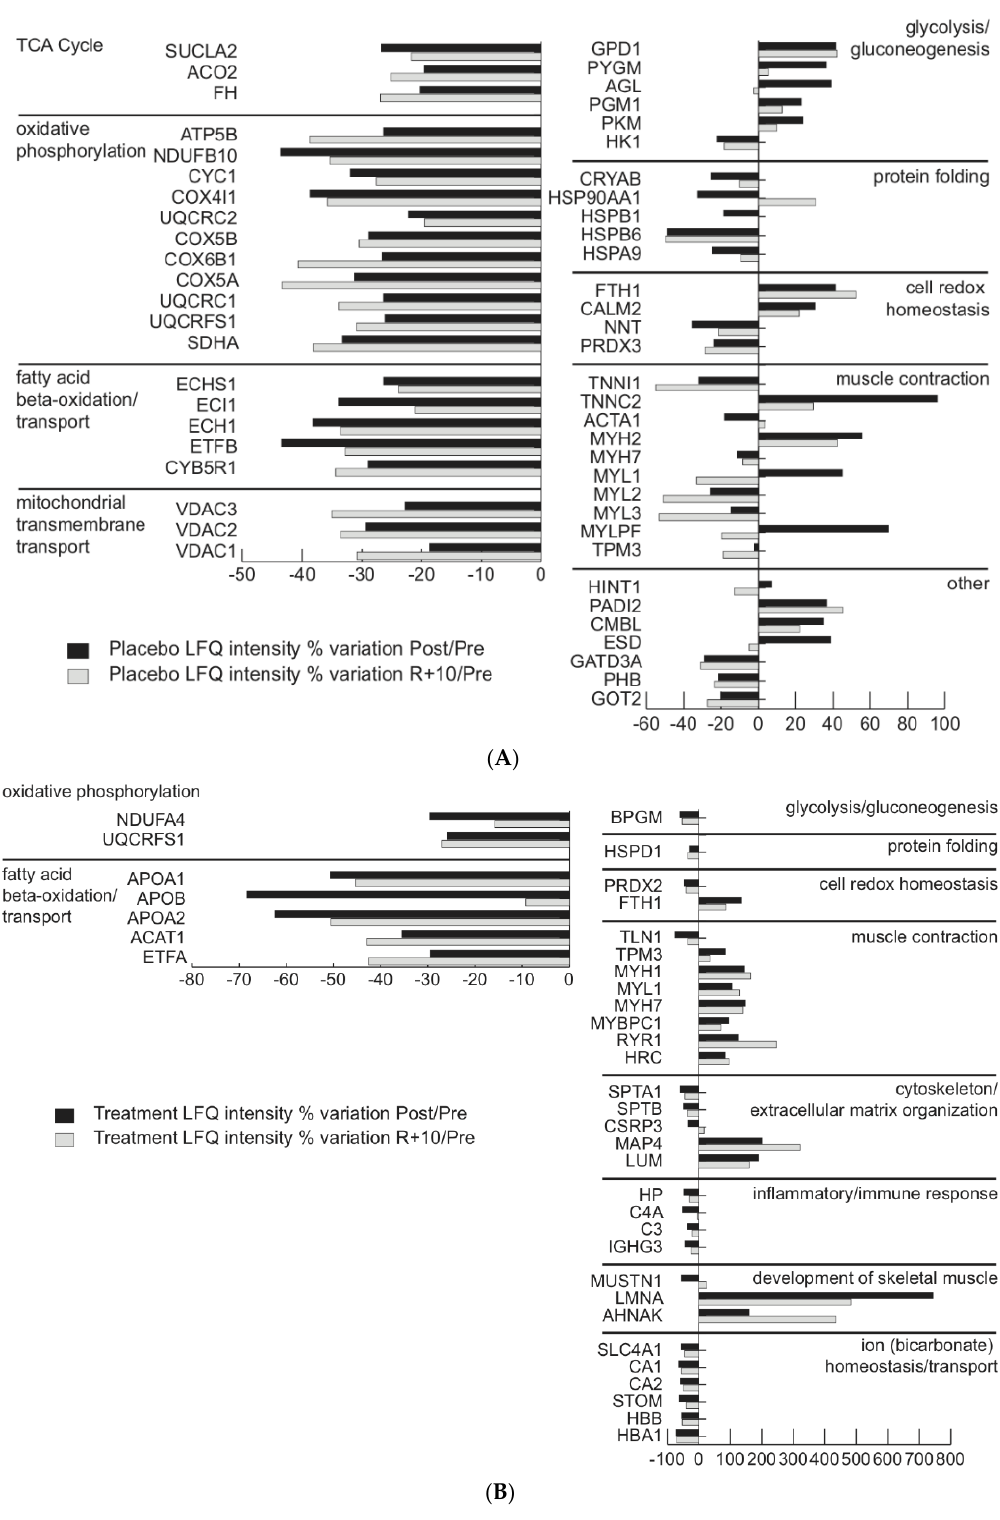
Figure 1. ( A ) Proteomic analysis of vastus lateralis ( VL ) muscles in the Placebo group. Histograms of differentially expressed proteins (label-free quantification (LFQ), intensity % variation, ANOVA and Tukey’s test, n = 5, p ≤ 0.05) in bedrest Placebo-Post (black bars) and Placebo-R + 10 subjects (gray bars) vs. Placebo-Pre condition. The individual variability within the group (Pre, Post, and R + 10) is shown in Figure S1. ( B ) Proteomic analysis of VL muscles in the Treatment group. Histograms of differentially expressed proteins (LFQ intensity % variation, ANOVA and Tukey’s test, n = 5, p ≤ 0.05) in bedrest Treatment-Post (black bars) and Treatment-R + 10 subjects (gray bars) vs. Treatment-Pre condition. The individual variability within the group (Pre, Post, and R + 10) is shown in Figure S2. Figure 1B graphically shows results from label-free LC – MS/MS differential analysis reported in Table S2 and indicates levels of proteins that are dysregulated by BR in Treat- ment-group in both Post and R + 10 vs. Pre. As a result, oxidative phosphorylation, cyto- chrome c oxidase subunit NDUFA4, and cytochrome b-c1 complex subunit Rieske (UQCRFS1) were decreased. Furthermore, fatty acid oxidation and lipid transport pro- teins were decreased. The glycolytic protein bisphosphoglycerate mutase (BPGB) and the mitochondrial chaperone protein 60 kDa heat shock protein (HSPD1) were also decreased. Relating to cell redox homeostasis, FTH1 increased and peroxiredoxin-2 (PRDX2) de- creased in Post and R + 10 vs. Pre. Altered levels of proteins involved in muscle contraction were found such as slow-twitch TPM3, MYH7, myosin-binding protein C (MYBPC), and fast-twitch myosin-1 (MYH1) and myosin light chain 1/3 (MYL1), which increased in Post and R + 10 vs. Pre. The costameric protein talin-1 (TLN1) also decreased, whereas calcium ion transport proteins ryanodine receptor 1 (RyR1) and sarcoplasmic reticulum histidine- rich calcium-binding protein (HRC) protein increased. Cytoskeletal proteins showed a dec- rement of spectrin alpha and beta chain (SPTA1, SPTB), whereas a promotor of myogenesis, cysteine, and glycine-rich protein 3 (CSRP3) and microtubule-associated protein (MAP4) protein increased. In addition, the extracellular matrix component lumican (LUM) in- creased. Transport and inflammatory/immune response proteins were decreased, whereas proteins involved in the development of skeletal muscle such as prelaminin A/C (LMNA) and neuroblast differentiation-associated protein (AHNAK) increased both in Post and R +